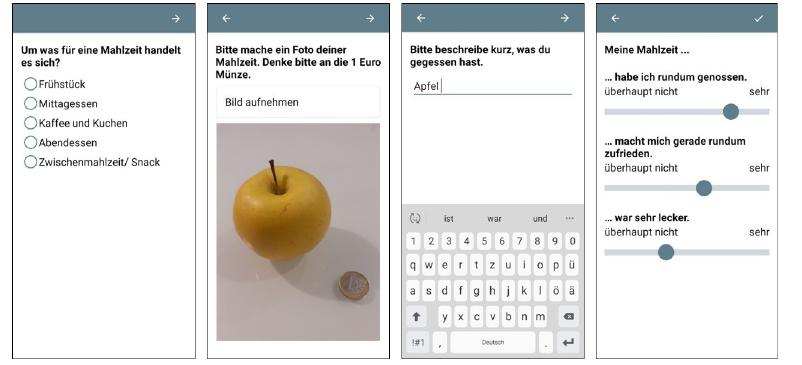
Fig 1. Screenshots of the app for assessing eating events and in-the-moment eating happiness.